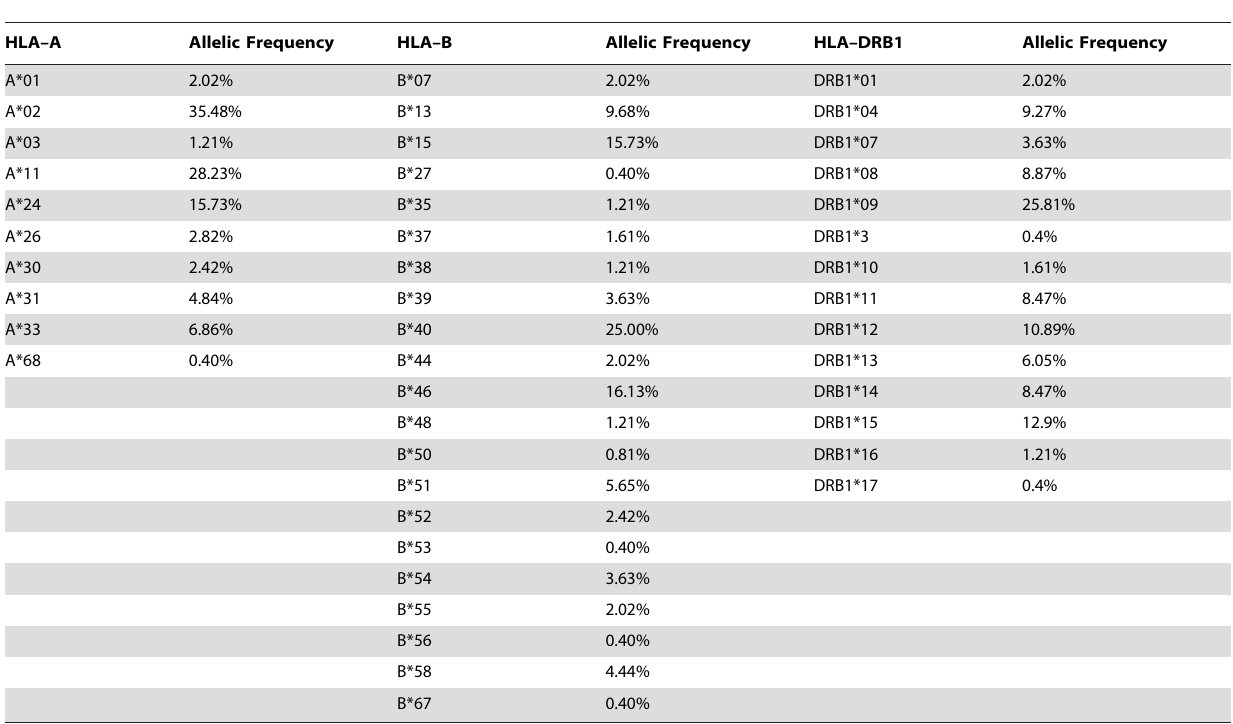
Table 2. Allelic frequencies of HLA–A, B and DRB1 loci in Tujia population living in Wufeng region, China.